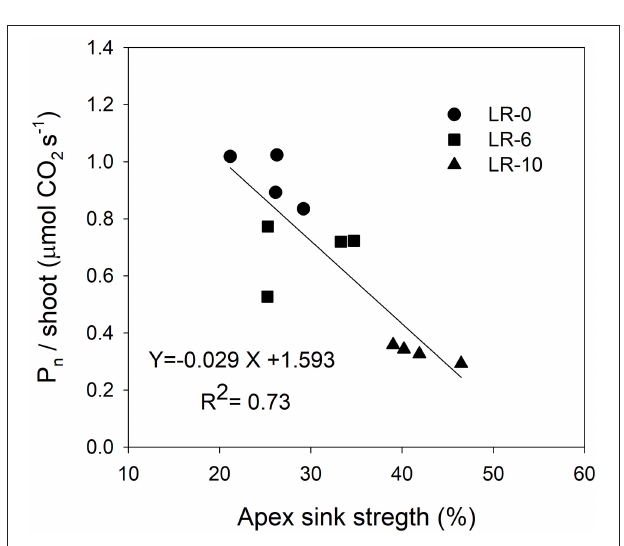
FIGURE 8 | Linear regression between shoot apex sink strength and shoot net photosynthesis (P n /shoot). Shoot apex sink strength was calculated as the mean of 13 C percentage allocation during the pulsing study (7 to 14 days after